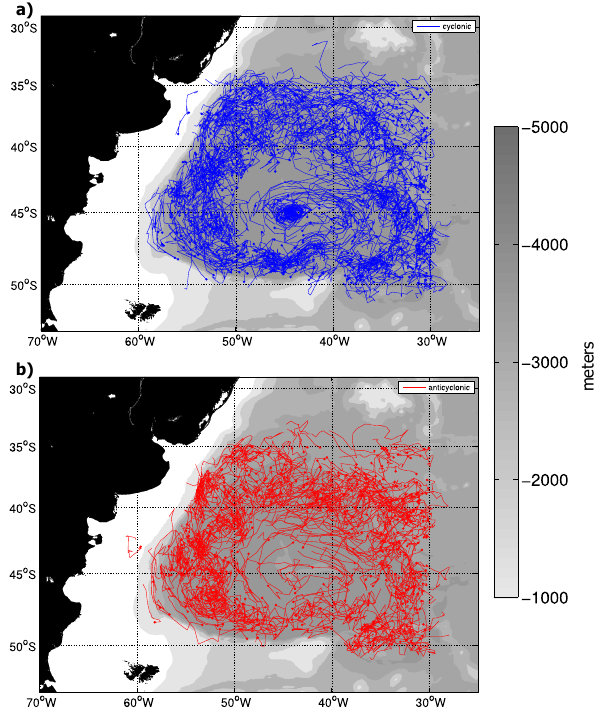
Figure 6. Trajectories of (a) cyclonic and (b) anticyclonic eddies first identified in the BC system between October 1992 and April